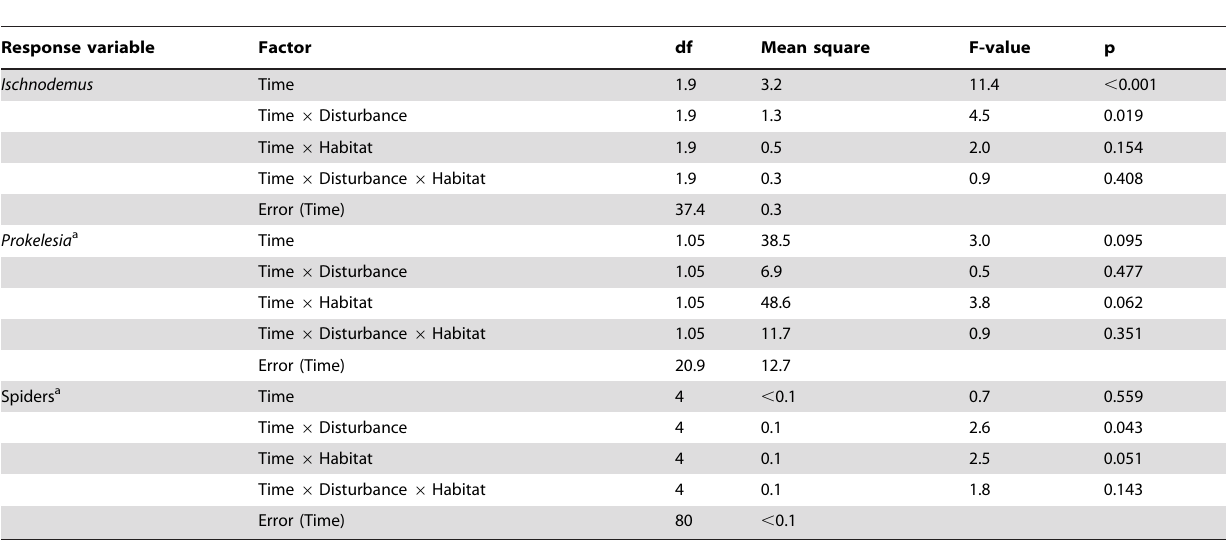
Table 2. Summary of two-way repeated-measures ANOVA results for arthropod densities in response to plant removal disturbance treatments in mound (small patch) and terrace (large patch) habitats over time.